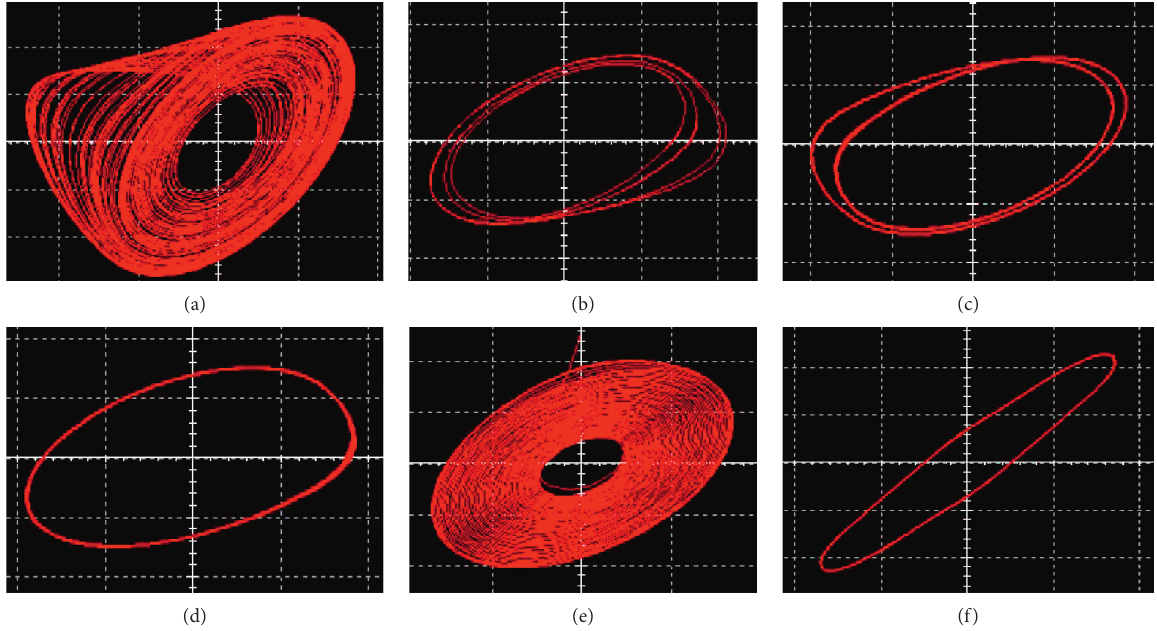
Figure 13: Multisim simulation of (a) single band chaotic attractor ( R � 1950 Ω ) , (b) period-4 limit cycle ( R � 1980 Ω ) , (c) period-2 limit cycle ( R � 1990 Ω ) , (d) period-1 limit cycle ( R � 2000 Ω ) , (e) steady state ( R � 2040 Ω ) , and (f) limit cycle ( R � 1100 Ω ) in x –y